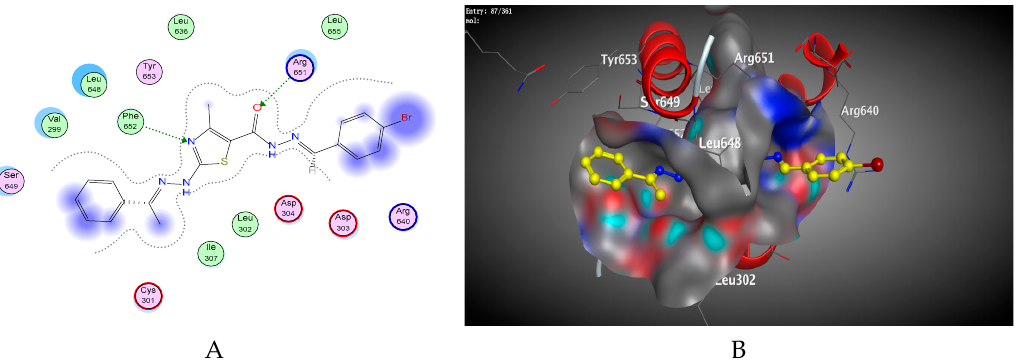
Figure 3. ( A ) 2D pose and ( B ) surface map of the interaction of 4b into the active sites of SARS-CoV-2 RdRp (PDB: 7bv2).